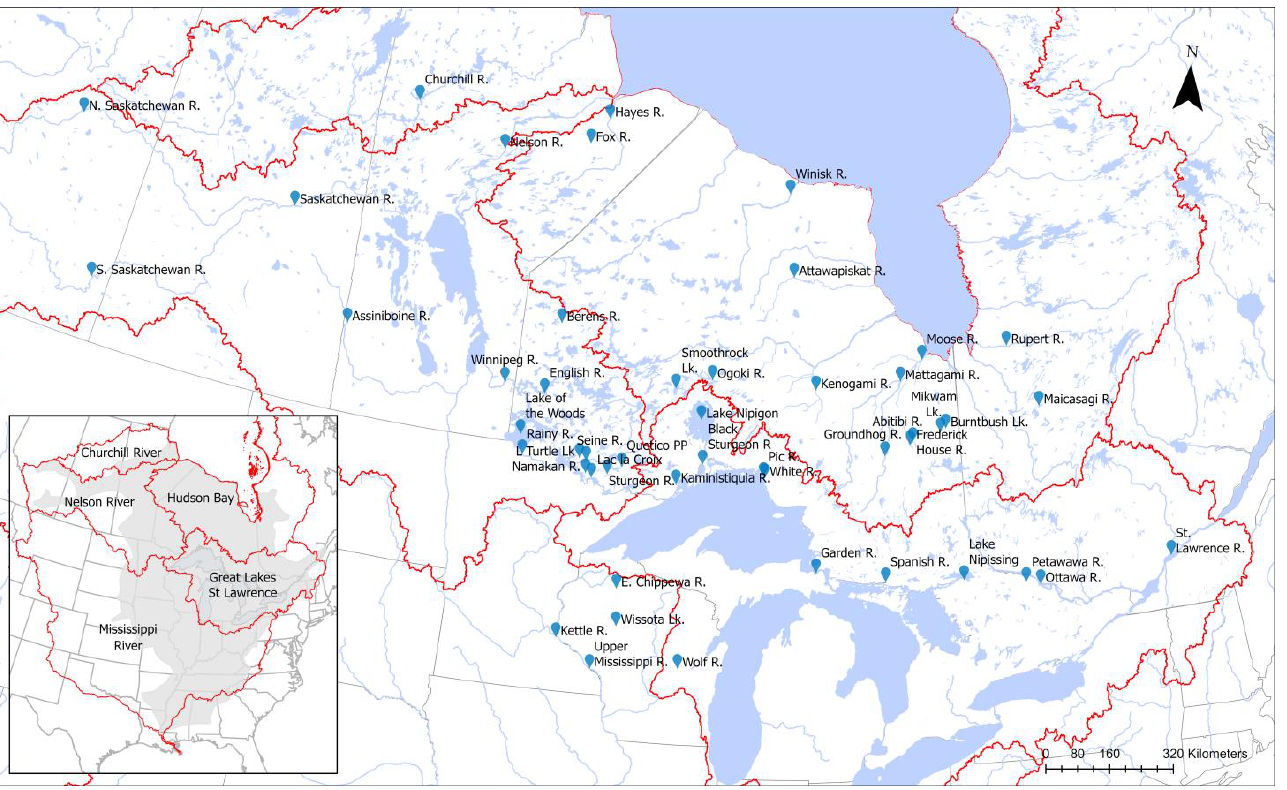
Figure 1. Locations of 49 sampled lake sturgeon populations, showing sampling locations within major watersheds. Inset map shows the study’s extent within the historical range of lake sturgeon (shaded area) across North America.